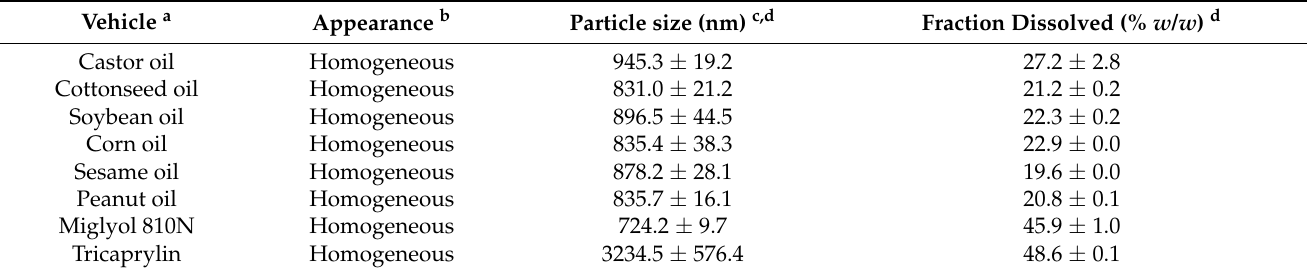
Table 2. Dispersibility, particle size, and solubilized fraction (%) of RTG OSs prepared with different oily vehicles using bead-milling